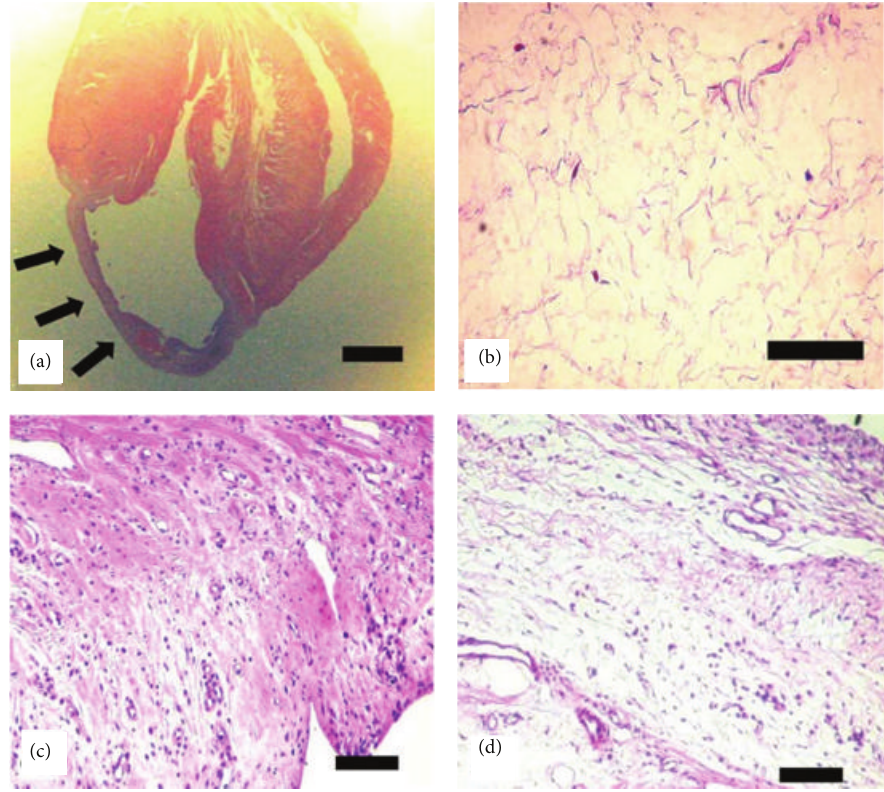
Figure 4: H&E staining of histological tissuesection. Myocardium wall became thin in theinfarction site(arrowsin (a)). No vessels and viable cells were observed in infarction site (b). After eight weeks, the treatment of cell transplantation with fibrin gel (c) demonstrated extensive tissue regeneration when compared with cell transplantation without fibrin gel (d). Scale bar indicates 2 mm (a) and 100 𝜇 m ((b), (c), and (d))